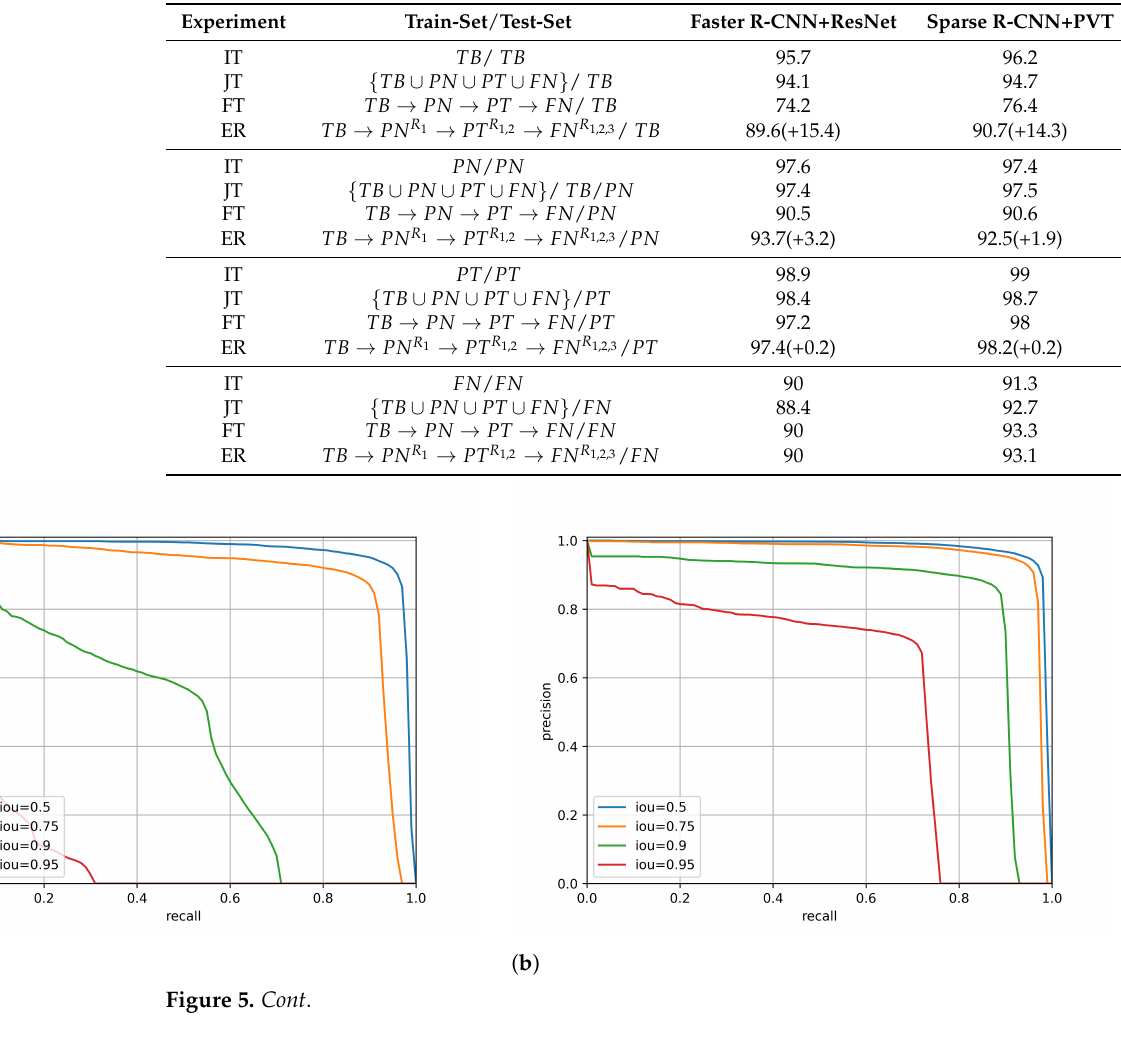
Table 2. The mAP results of different experiments on multiple test-sets. IT is the Independent training, JT is the Joint training, FT is the Fine-tuning, and ER is the Experience replay. the values written in the parentheses in the ER experiment demonstrate the difference in the mAP metrics between the ER and FT approaches. Acronyms TB, PN, PT, and FN denote TableBank, PubLayNet, PubTables-1M, and FinTabNet, respectively. The R superscripts for ER, demonstrate the index of the previous datasets contributing to the replay memory.